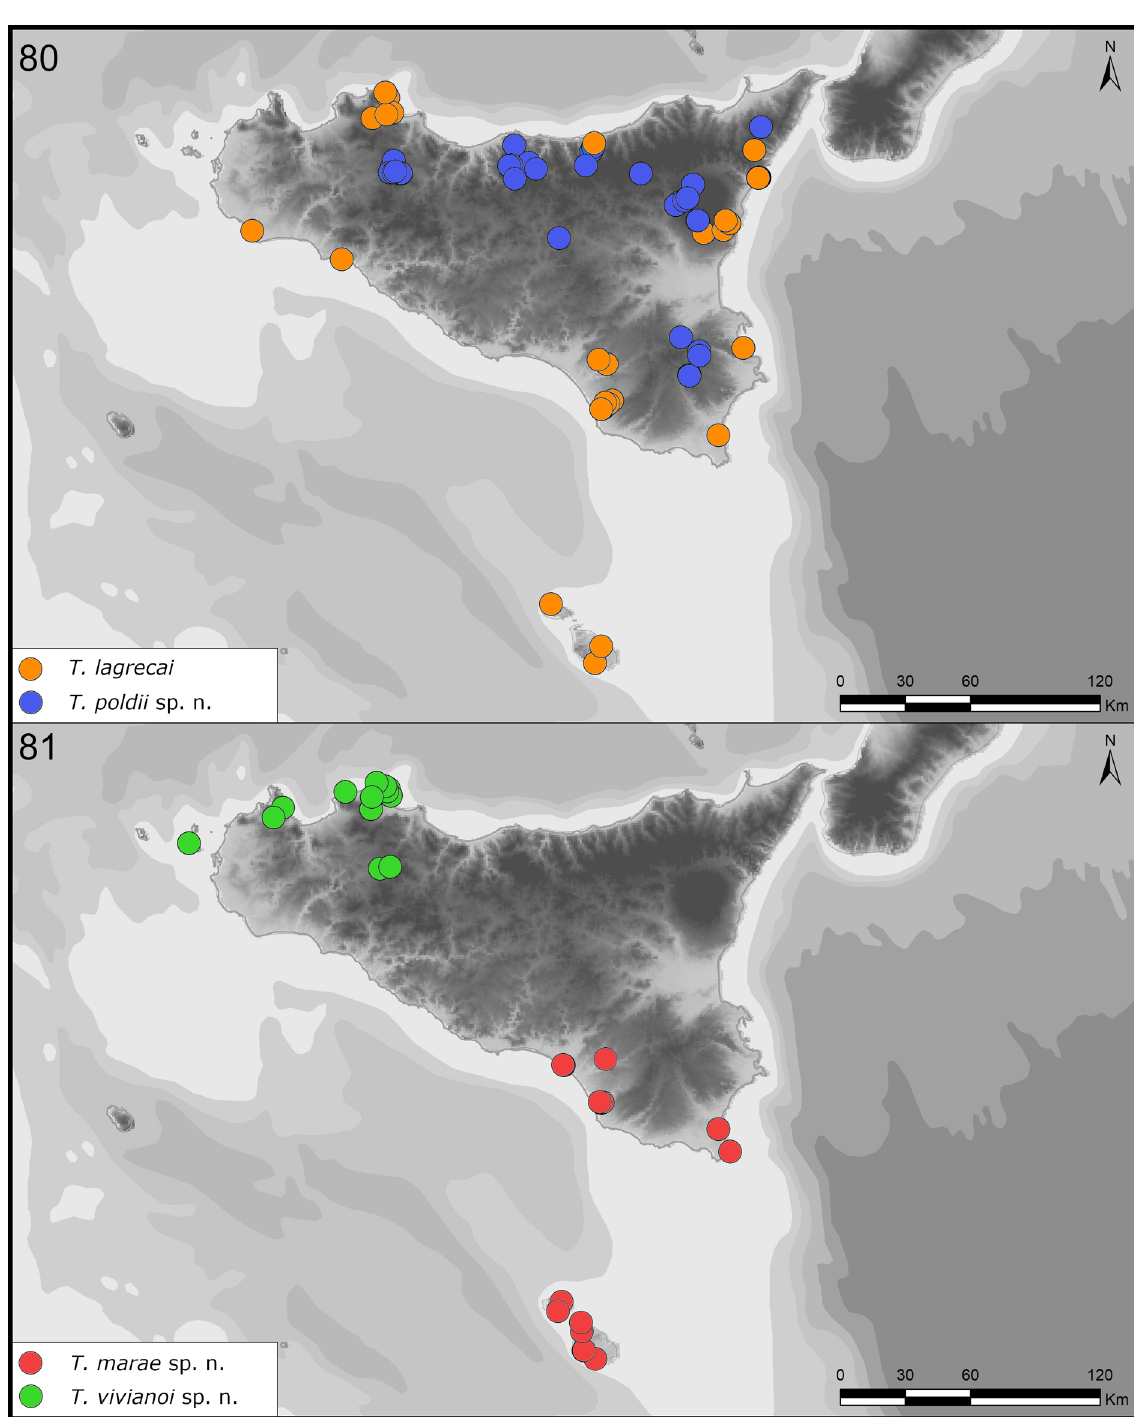
Figs 80–81. Geographic distribution of the four taxa treated in this study. Note that the shallow water area (light grey) between Sicily and the Maltese Islands roughly corresponded to a land bridge during